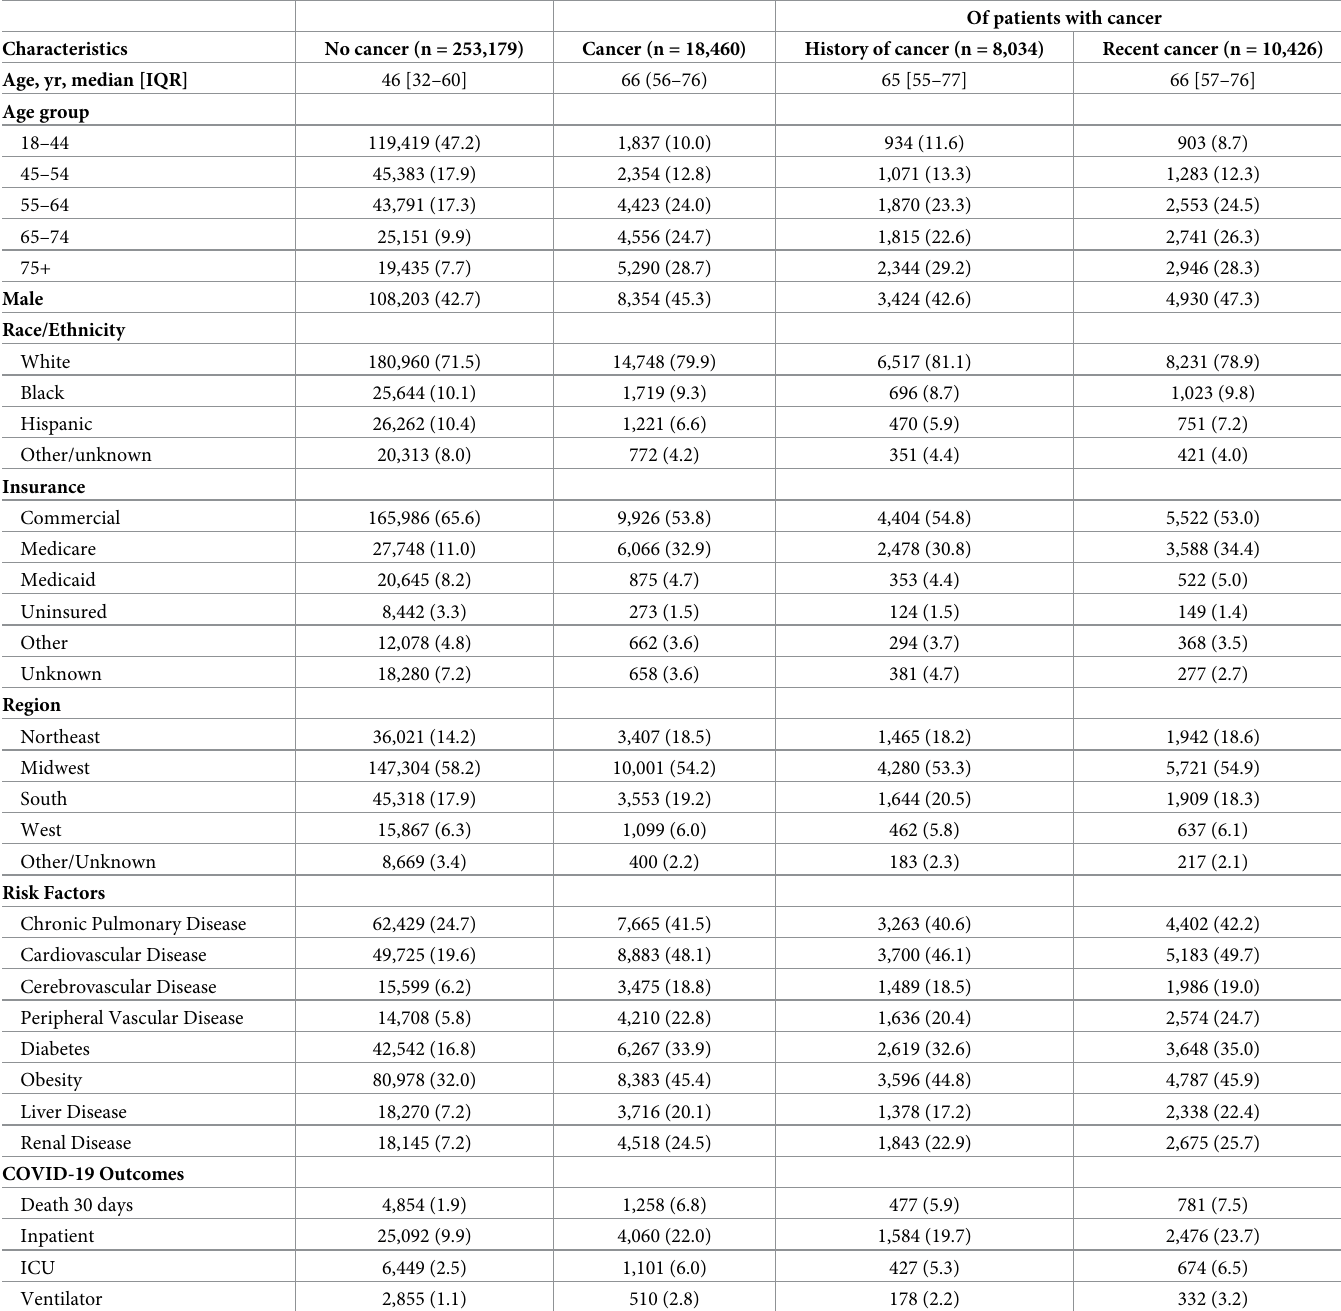
Table 1. Characteristics of patients in COVID-19 with or without cancer a .